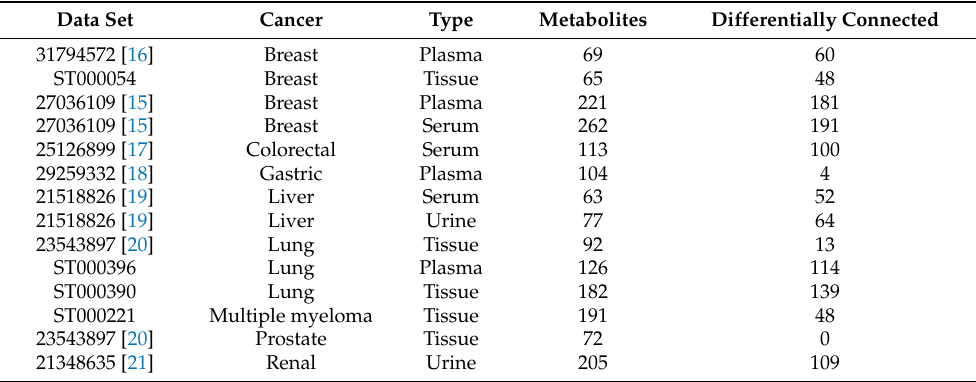
Table 4. Overview of the number of significantly differentially connected metabolites per data set and cancer type (Benjamini–Hochberg adjusted p -value p adj < 0.05) according to inferred metabolite association